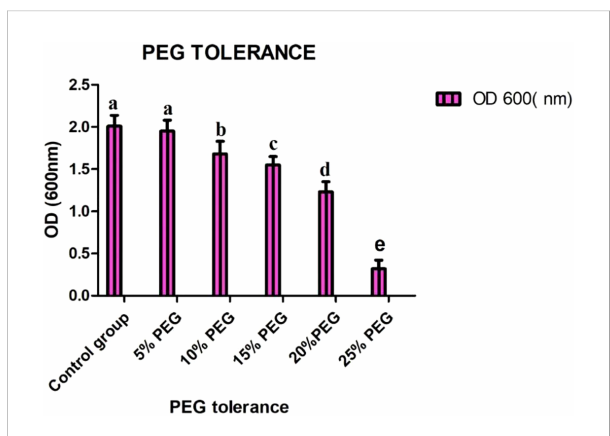
FIGURE 5 Growth of SH-8 with different concentrations of PEG 6000. Each data point is the mean of fi ve replicates. The error bar represents the standard error. Different lowercase letters indicate signi fi cant difference in